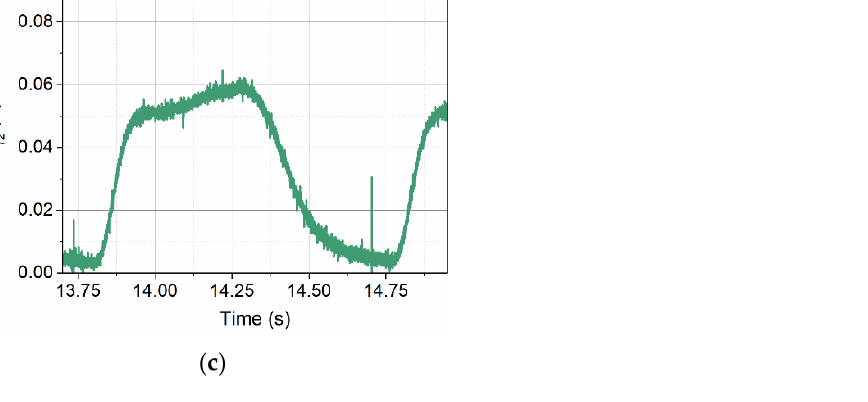
Figure 6. Pulse shapes recorded by detector T2 for three thermal wave frequencies: f = 0.25 Hz ( a ), f = 0.50 Hz ( b ), and f = 1.00 Hz ( c ), at the inflow velocity v ∞ = 0.065 m/s.